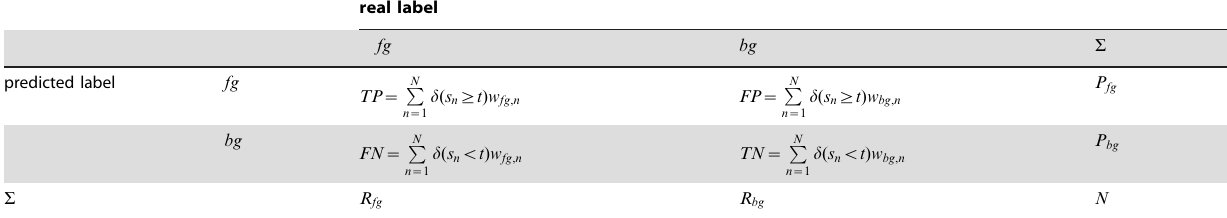
Table 1. Binary confusion matrix.